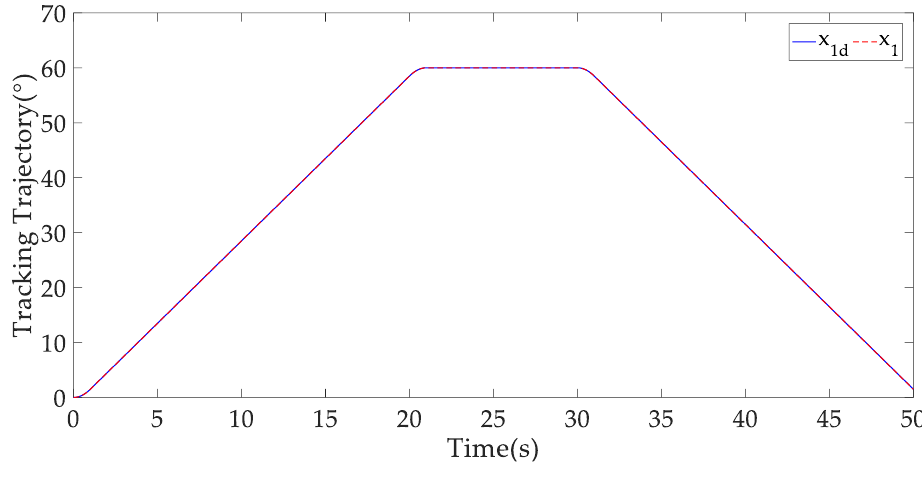
Figure 8. The tracking trajectory of NRC.